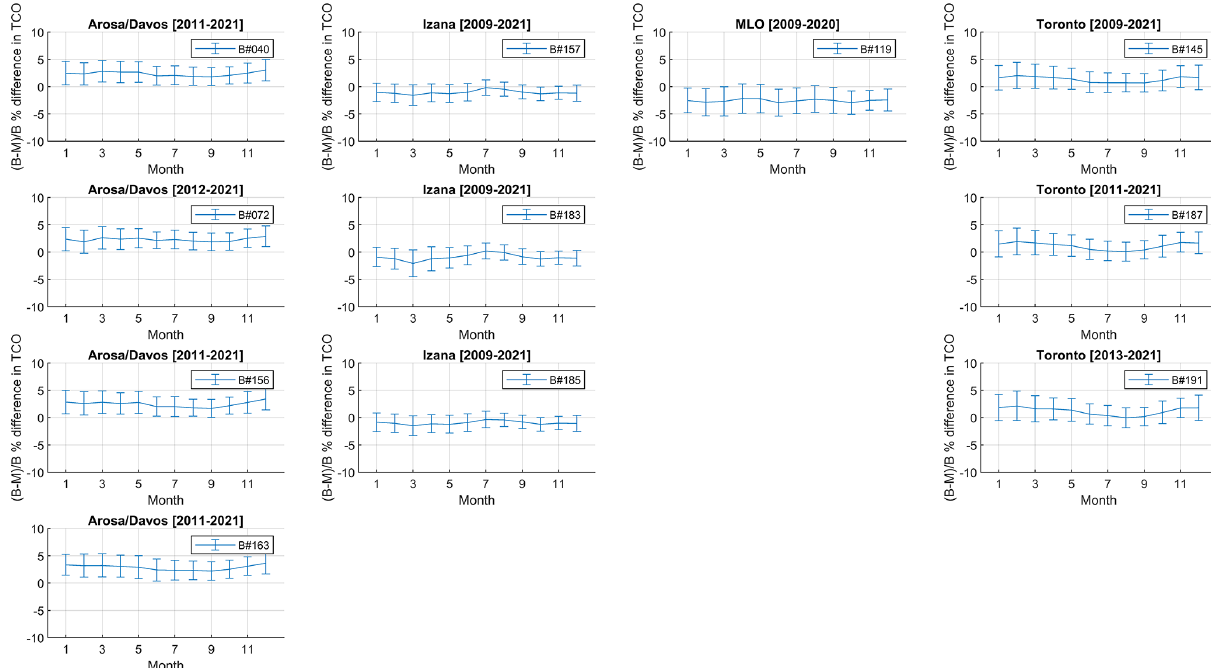
Figure A2. Brewer and MERRA-2 TCO percent difference binned by month. The percentage difference is calculated as ( Brewer − MERRA-2 )/ Brewer. Error bars are the 1 σ of the monthly percentage difference. The site and data period are shown in the title of each panel. The Brewer instrument numbers are given in the